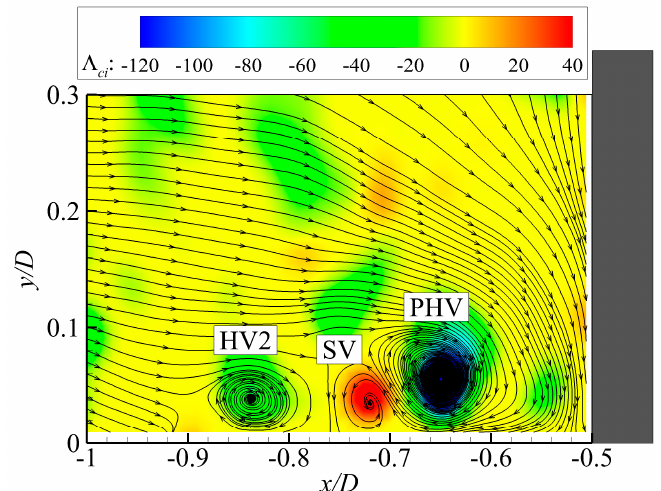
Figure 2. Streamlines and contours of swirling strength in an instantaneous flow field in front of the cylinder for case 8600.